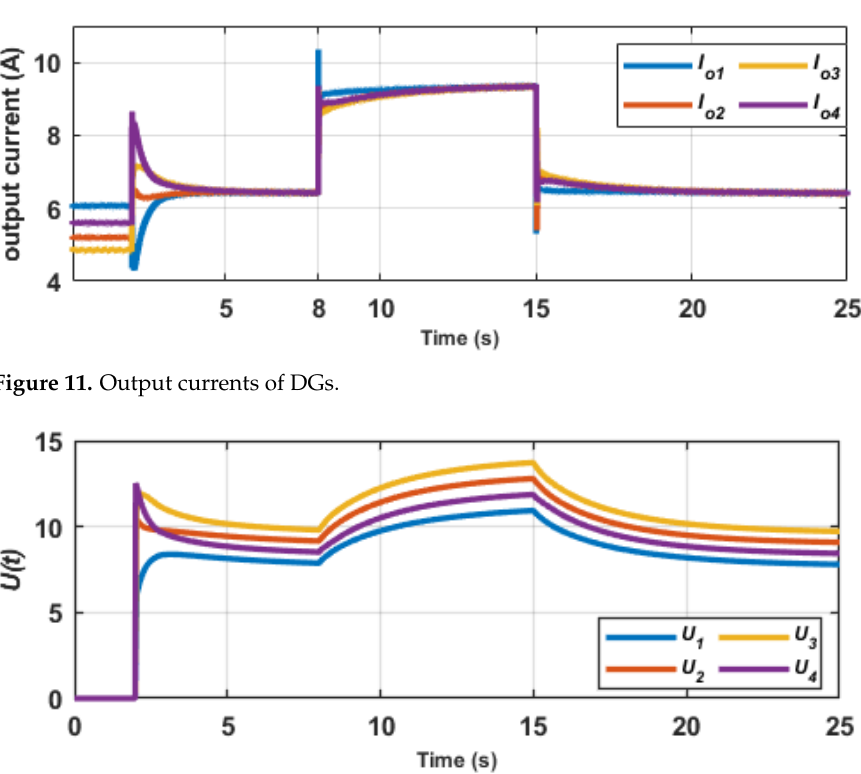
Figure 10. ( a ) DC bus voltage; ( b ) output voltage of DGs.